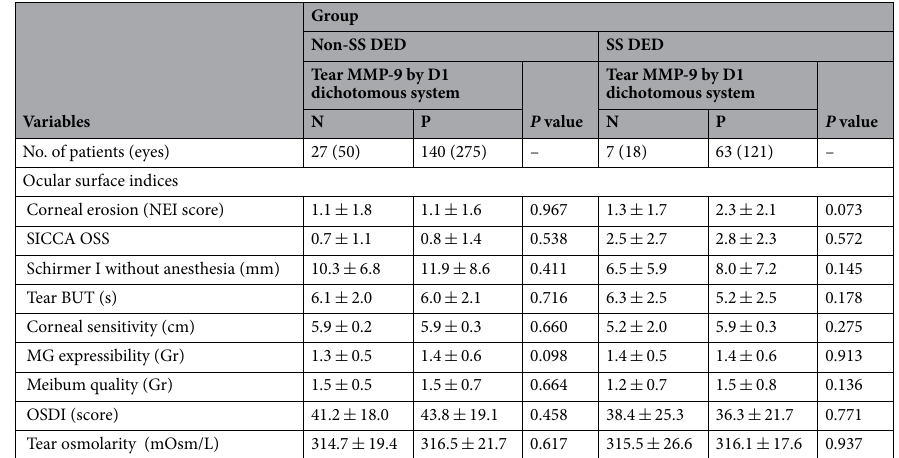
Table 2. Ocular surface indices according to D1 dichotomous system for tear matrix metalloproteinase 9 (MMP-9) expression in subjects with dry eye disease (DED) with and without primary Sjogren’s syndrome (pSS). N, negative. P, positive. Gr, grade. OSDI, ocular surface disease index. OSS, ocular staining score. BUT, break-up time. MG, meibomian gland.